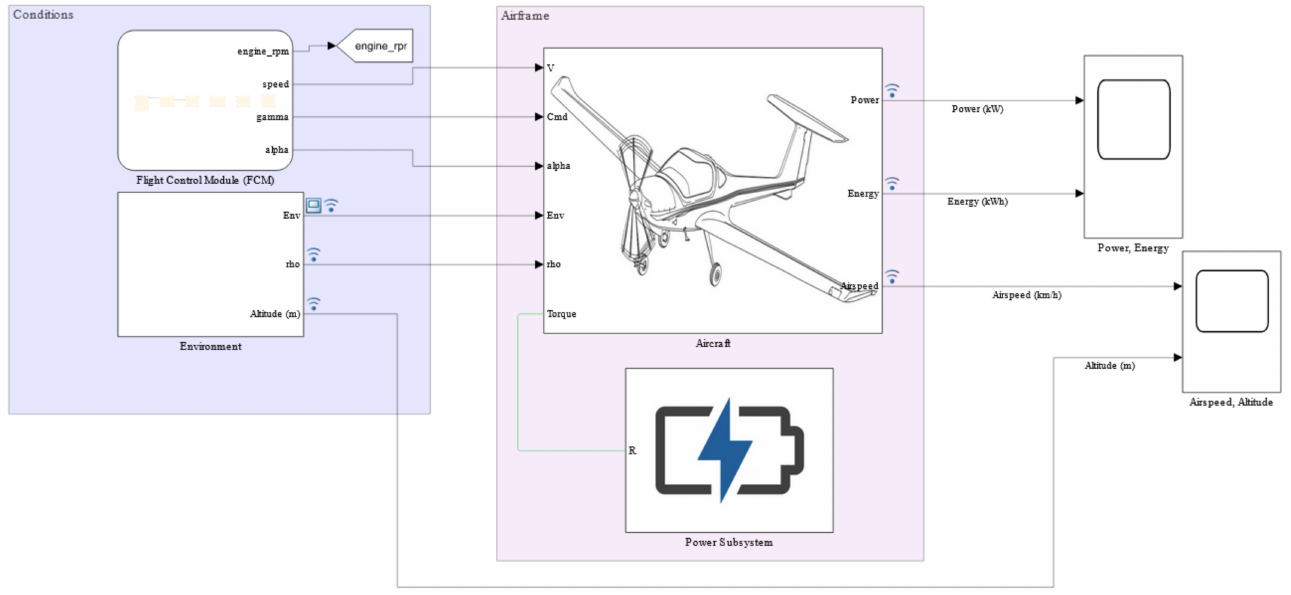
Figure A1. The simulation model of electric aircraft developed in the MATLAB-Simulink environ-